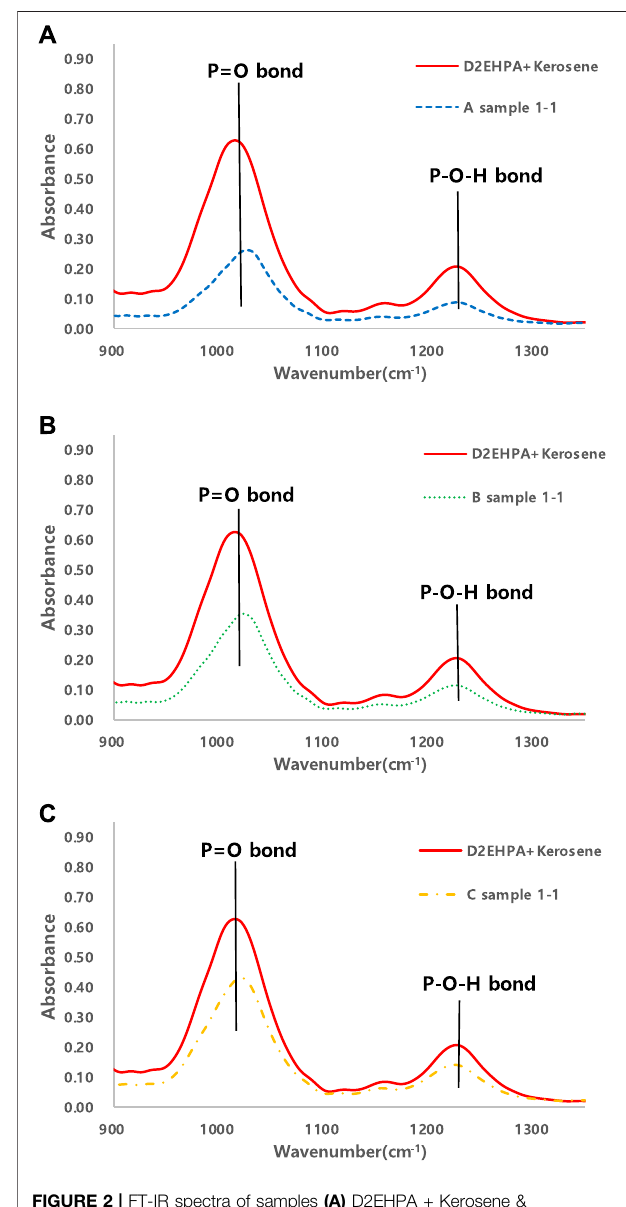
FIGURE 2 | FT-IR spectra of samples (A) D2EHPA + Kerosene & D2EHPA + Kerosene after the 1 st stage solvent extraction of the geothermal water without SiO 2 ; (B) D2EHPA + Kerosene & D2EHPA + Kerosene after the 1 st stage of solvent extraction of the geothermal water that contained